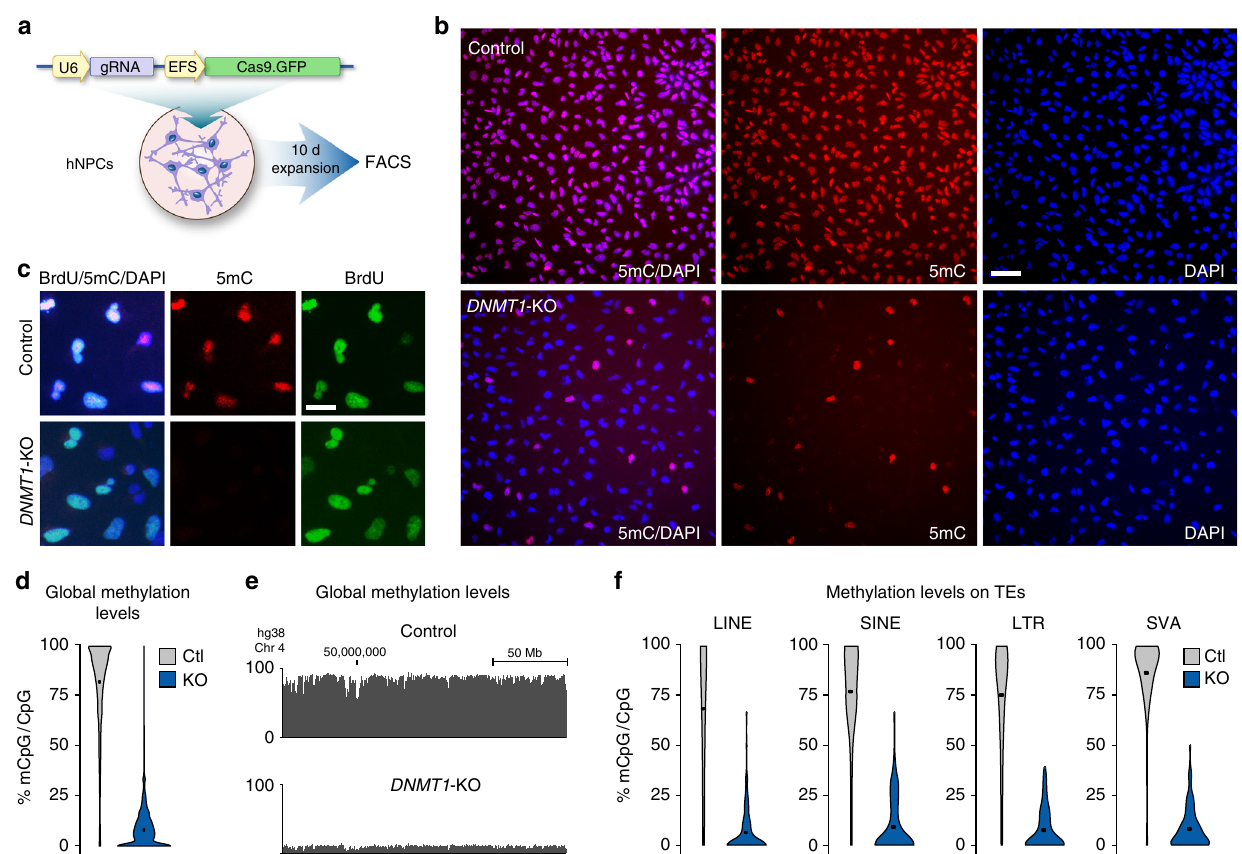
Fig. 1 Disruption of DNMT1 in hNPCs leads to global loss of DNA methylation. a Schematic work fl ow of generation of DNMT1 -KO hNPCs using LV.CRISPR- DNMT1. b Fluorescent immunostaining of 5mC 10 days post transduction with LV.CRISPR-DNMT1 and the control vector, scalebar 70 μ m. c Control and DNMT1 -KO hNPCs were allowed to incorporate BrdU between days 10 – 15 post transduction. Fluorescent immunostaining of 5mC and BrdU revealed that DNMT1 -KO cells continued to divide and incorporate BrdU even after loss of DNA methylation, scalebar 25 μ m. d The distribution of genome-wide mCpG/ CpG ratios of 1 kb tiles is shown by Violin plots. Each data point is the mean mCpG/CpG ratio within each 1 kb tile. The black dot shows the mean of all 1 kb bin means. e UCSC screenshot of a part of chromosome 4 shows global loss of CpG methylation upon loss of DNMT1. f Violin plots show distribution of mCpG/CpG within all LINE, SINE, LTR, and SVA elements in hg38. The black dot shows the mean of all